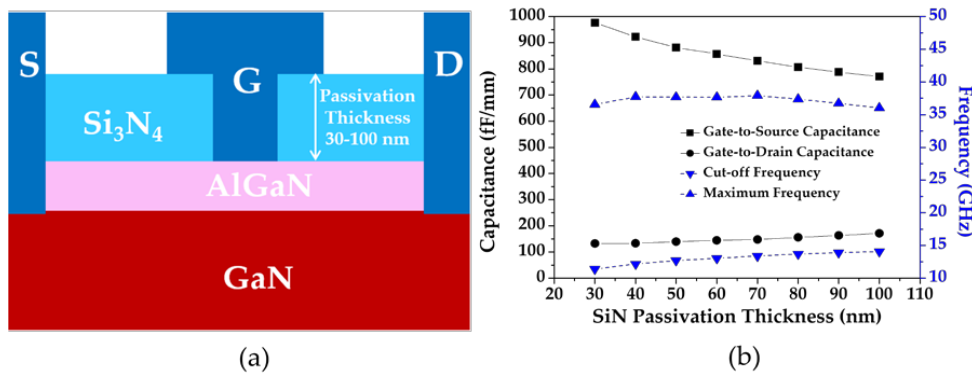
Figure 12. ( a ) Schematic of the structure; ( b ) capacitance and frequency variations as a function of Si 3 N 4 passivation thickness.